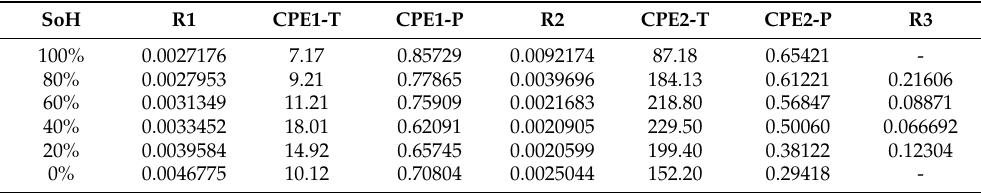
Table 1. Parameters extracted from the EIS using manual adjustments in the Zview software. SoH